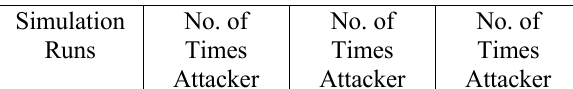
Table 8. Performance evaluation table for real to real